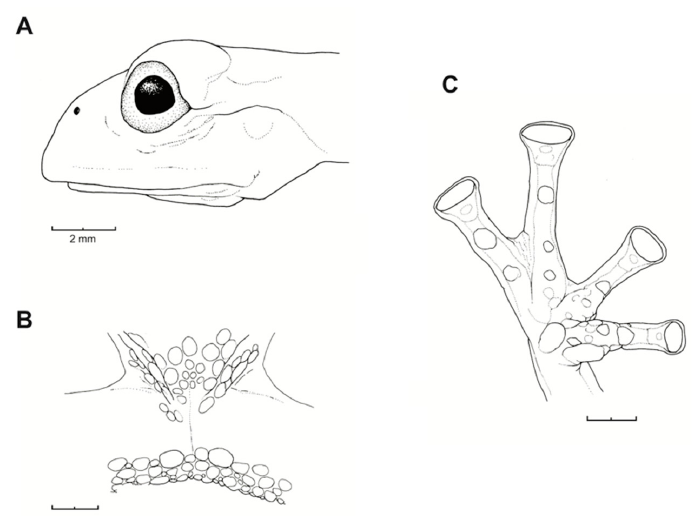
Figure 26. Centrolene buckleyi . ( A ) Head in lateral view, adult female, KU 178035. ( B ) Venter and thighs in ventral view, adult female, KU 178040. ( C ) Hand in ventral view, adult female, KU 178055. Illustrations by Juan M. Guayasamin.